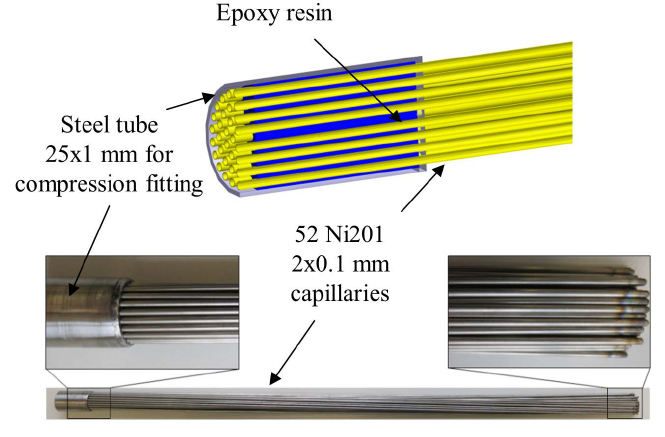
Figure 2. Membrane bundle with CAD (Computer aided design) sketch of the developed epoxy resin membrane